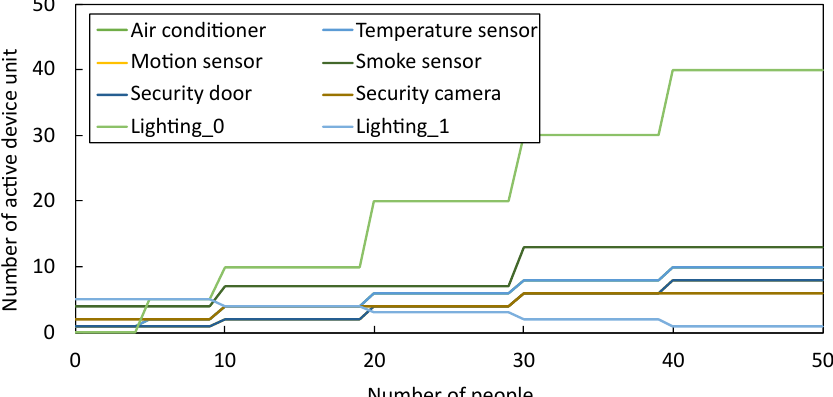
Figure 13. The number of people inside the office for one day.